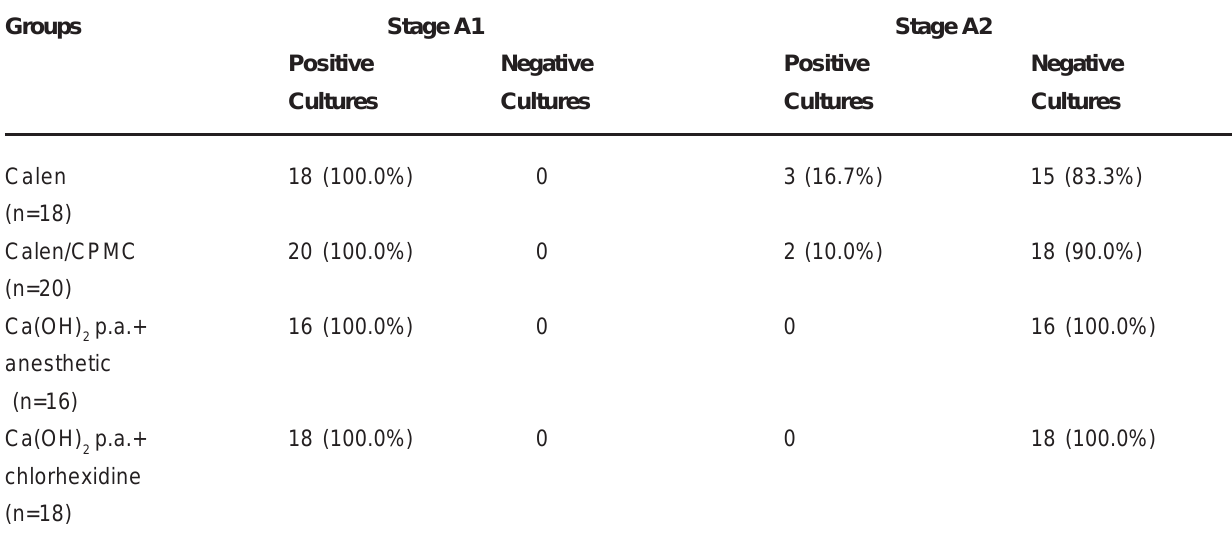
TABLE 3- Microbiological conditions of the root canals in Tio’s medium in A1 and